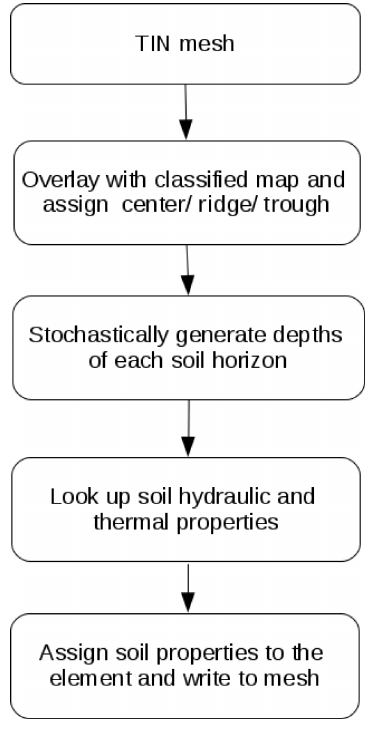
Figure 4. Workflow for heterogeneous soil parameter assignment in the computational